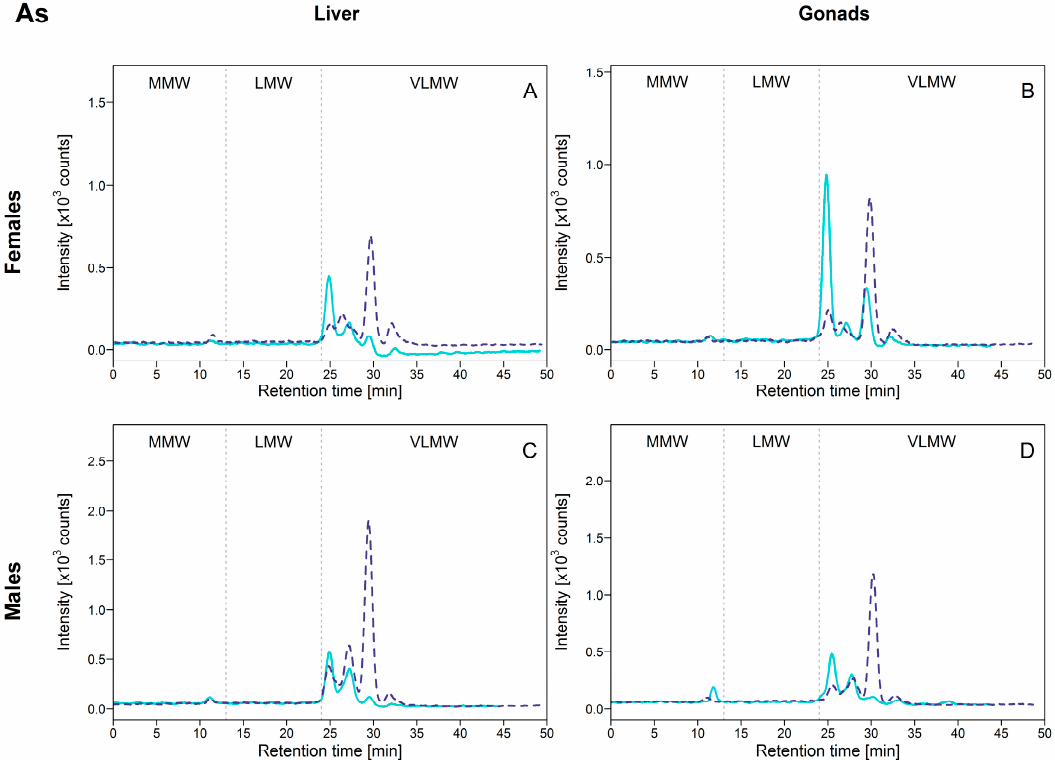
Figure 4. Size-exclusion chromatograms of As-binding biomolecules in hepatic and gonadal HSP fractions of white suckers from a reference (full line) and metal-impacted lake (dotted line). Vertical dotted lines delimit the three operationally defined molecular weight biomolecule pools: MMW (0–13 min; >10 kDa), LMW (13–24 min; 10–2 kDa) and VLMW (>24 min; <2 kDa). ( A ) Female liver; ( B ) Female gonads; ( C ) Male liver; ( D ) Male gonads.